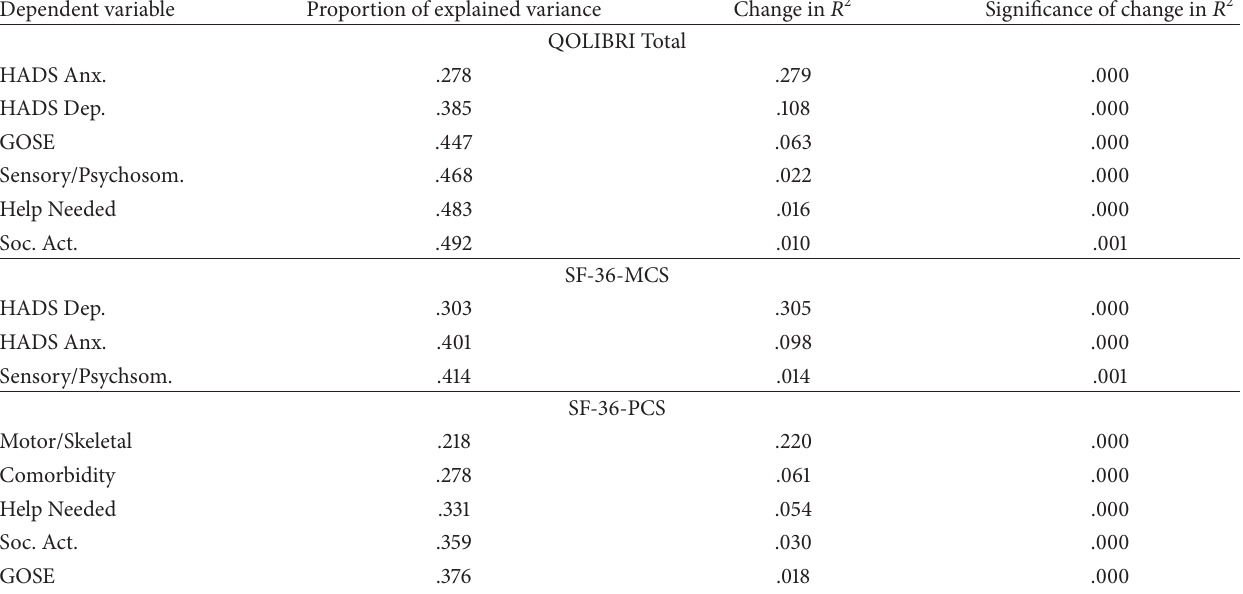
Table 3: Results of the stepwise regression